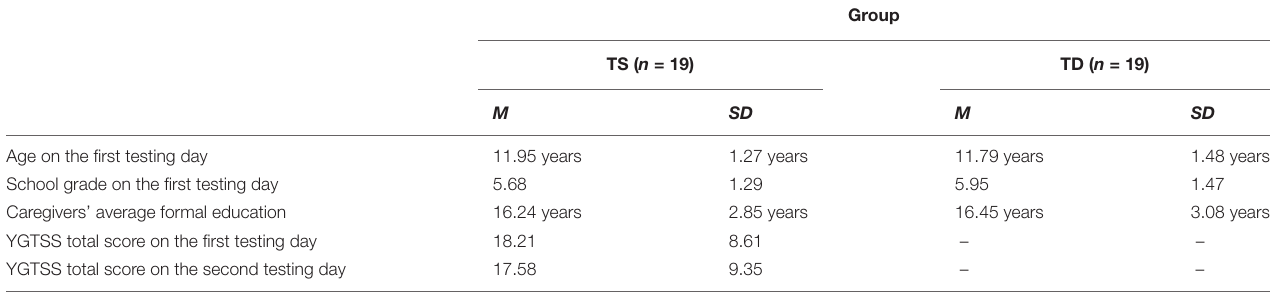
TABLE 1 | Demographic and clinical data of the